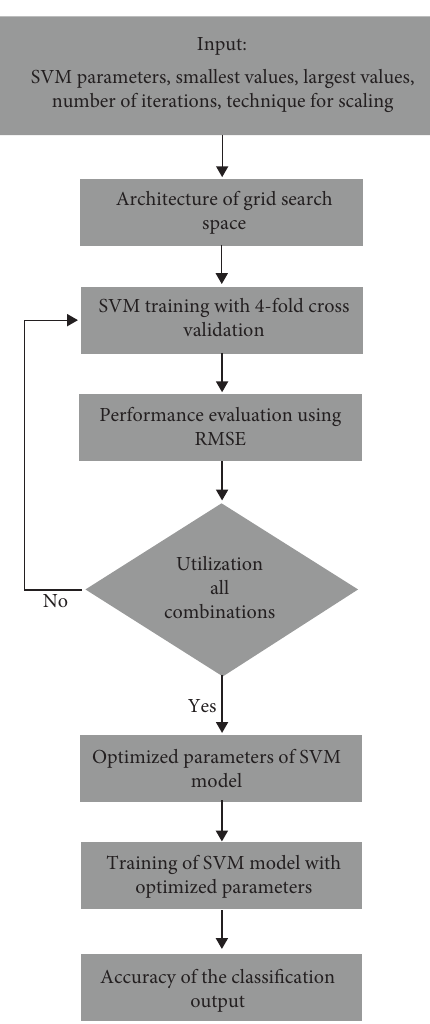
Figure 2: Tuning of SVM parameters using a grid search.